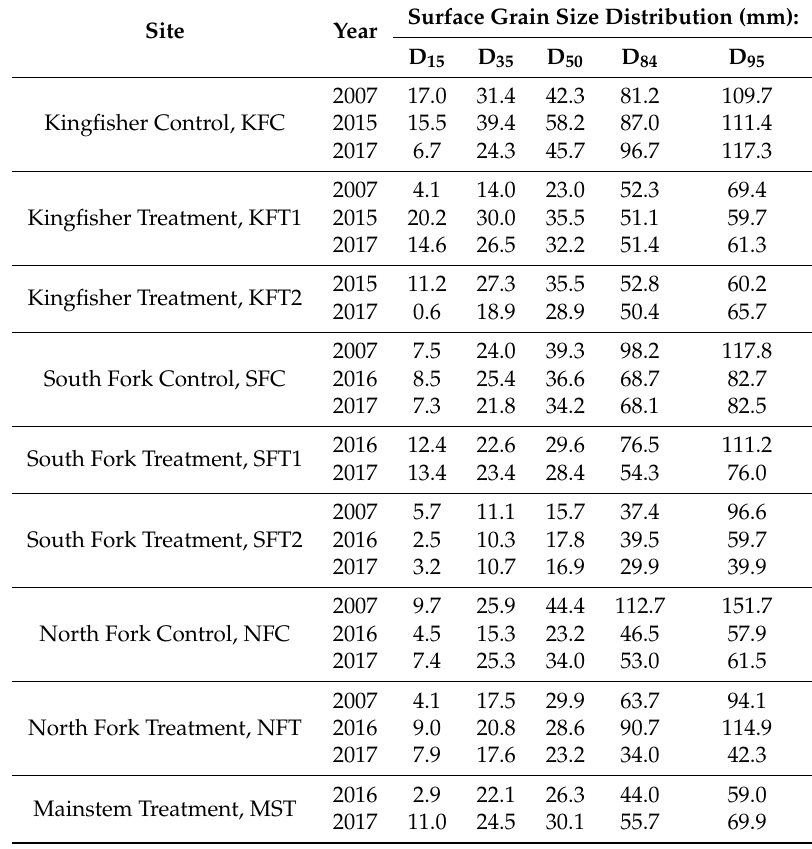
Table A1. Streambed surface layer grain size statistics for all 9 Thornton Creek sites (see Figure